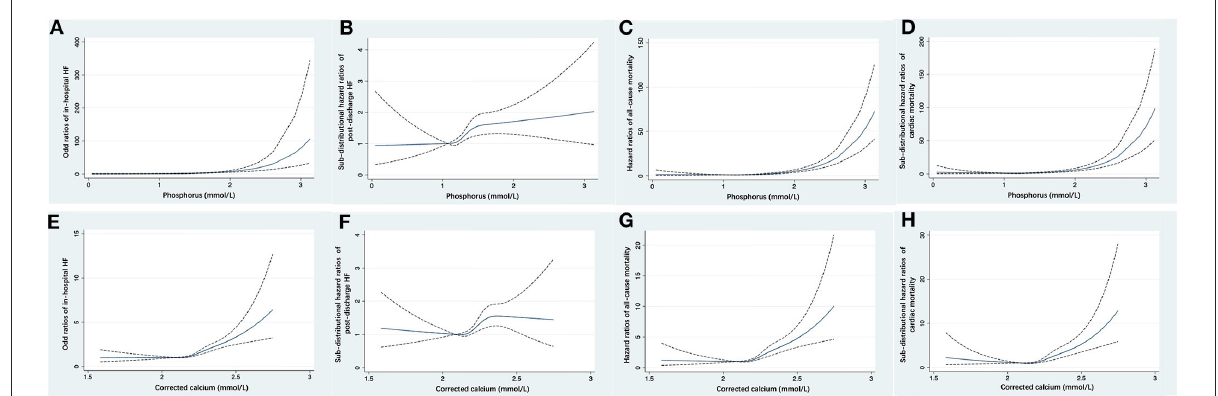
FIGURE3 Restricted cubic spline fitting for the association of serum phosphorus with the risk of in-hospital HF (A) , post-discharge HF (B) , all-cause mortality (C) , and cardiac mortality (D) , and the association of corrected serum calcium with the risk of in-hospital HF (E) , post-discharge HF (F) , all-cause mortality (G) , and cardiac mortality (H) . ORs or HRs were evaluated based on a univariate logistic regression or Cox proportional regression model. The area between dotted lines represents the 95% CI. CI, confidence interval; HF, heart failure; HR, hazard ratio; OR, odds ratio.